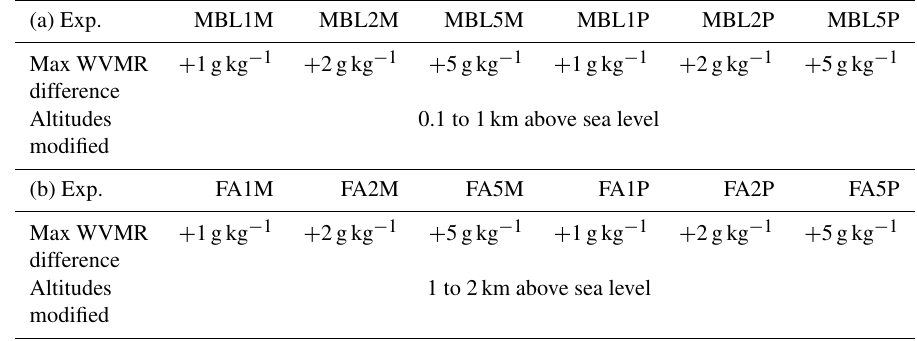
Table 1. List of sensitivity experiment and WVMR modifications with respect to the control simulation (CNTL). (a) Exp. MBL1M MBL2M